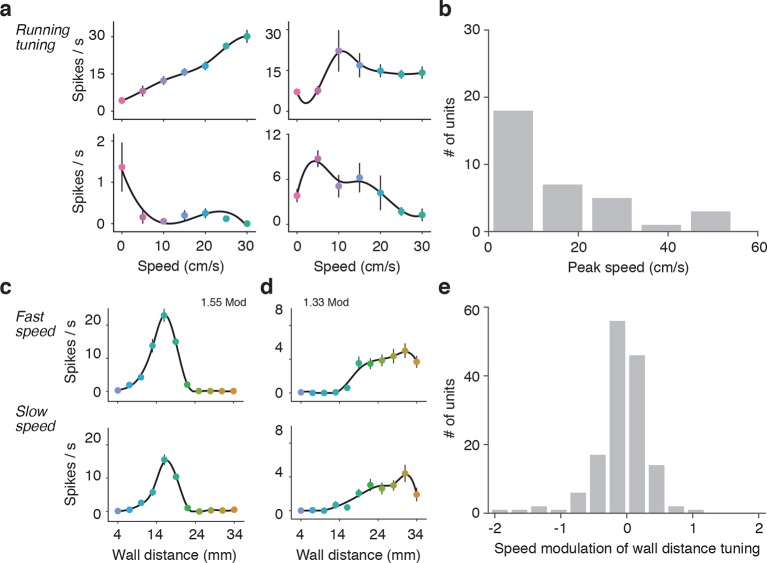
Effects of running speed on activity and wall distance tuning.(a) Four example units that showed significant tuning to running speed when the wall was out of reach. The activity of the top left unit increased linearly with speed over a large range, the activity of top right unit increased rapidly and then saturated at low speeds, the activity of the bottom right unit peaked at low speeds and then decreased at higher speeds, and the activity of bottom left unit decreased with running speed. (b) Histogram of the peak speed tuning for units significantly tuned to speed (31%; 46/148) from the population used in Figure 4. (c) Example wall distance tuning curve while the mouse is running in fast trials (top) and slow trials (bottom). Fast and slow trials were split based on the median of the trial speeds in trials when the mouse was running. This unit is the same as used in Figure 4—figure supplement 3a). (d) Example wall distance tuning curve while the mouse is running fast trials (top) and slow trials (bottom). This unit is the same as used in Figure 4—figure supplement 3b). (e) Histogram of the modulation of wall distance tuning by speed for all 148 units. This index was the log of the gain parameter that describes a multiplicative scaling of the slow tuning curve to the fast tuning curve. Units that are more active during fast running have positive modulation indices, units that are less active during fast running have negative indices.